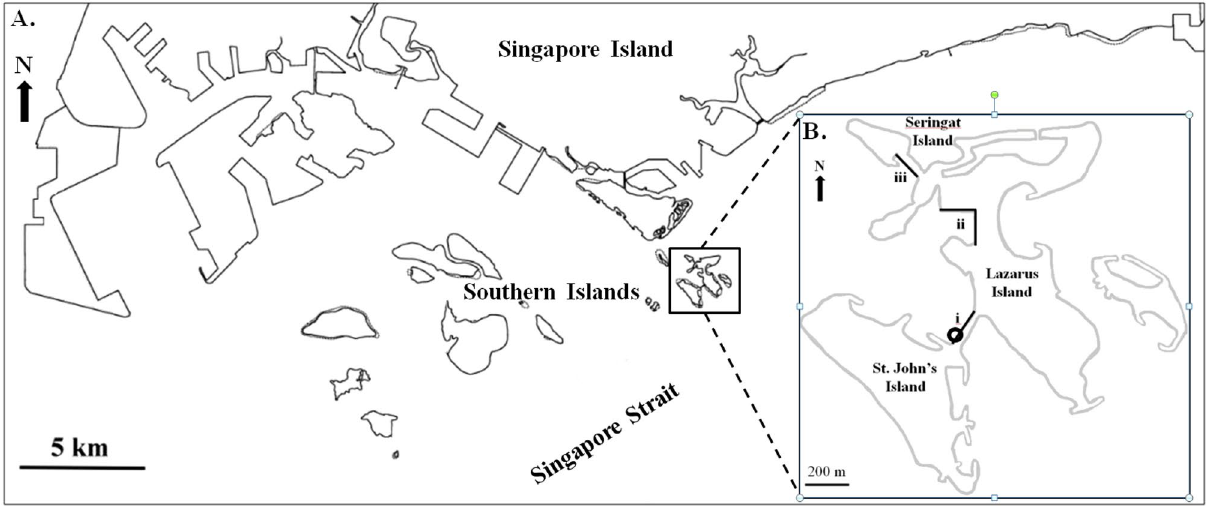
Figure 3. Map ( A ) shows the southern coastline of Singapore Island and the outlying Southern Islands in the Singapore Strait; Map ( B ) indicates the location of seawall sites examined i.e., (i) St. John’s Island (SJI)-Lazarus Causeway (N 1° 13 ′ 17.8 ′′ E 103° 51 ′ 05.7 ′′ ), (ii) Lazarus Island (N 1° 13 ′ 40.1 ′′ E 103° 51 ′ 05.7 ′′ ) and (iii) Seringat Island (N 1° 13 ′ 48.3 ′′ E 103° 50 ′ 55.8 ′′ ), the length of seawall surveyed (black straight line) and the in-situ experimental site (circled in black). Both maps were generated from Google Maps in which Map ( A ) was traced by hand, whilst Map ( B ) was extracted directly from Google Maps and modified using Microsoft PowerPoint 2010 and Paint